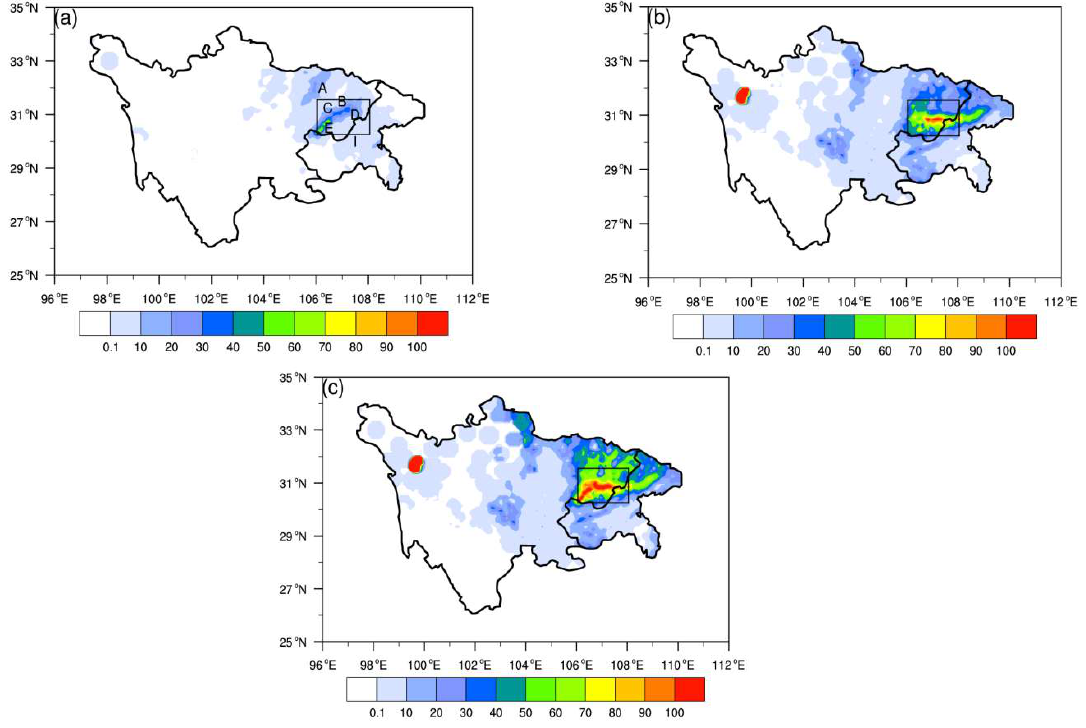
Figure 2. Spatial distribution of cumulative precipitation in the process (mm). ( a ) Cumulative precipitation in the first stage from 2300 UTC 1 May to 0300 UTC 2 May. A, B, C, D, E, and I represent Guangyuan, Bazhong, Nanchong, Dazhou, Guangan, Chongqing, respectively; ( b ) cumulative precipitation in the second phase from 1700 UTC 2 May to 0100 UTC 3 May; ( c ) total cumulative precipitation from 2300 UTC 1 May to 0100 UTC 3 May. Black rectangles represent the major precipitation area.